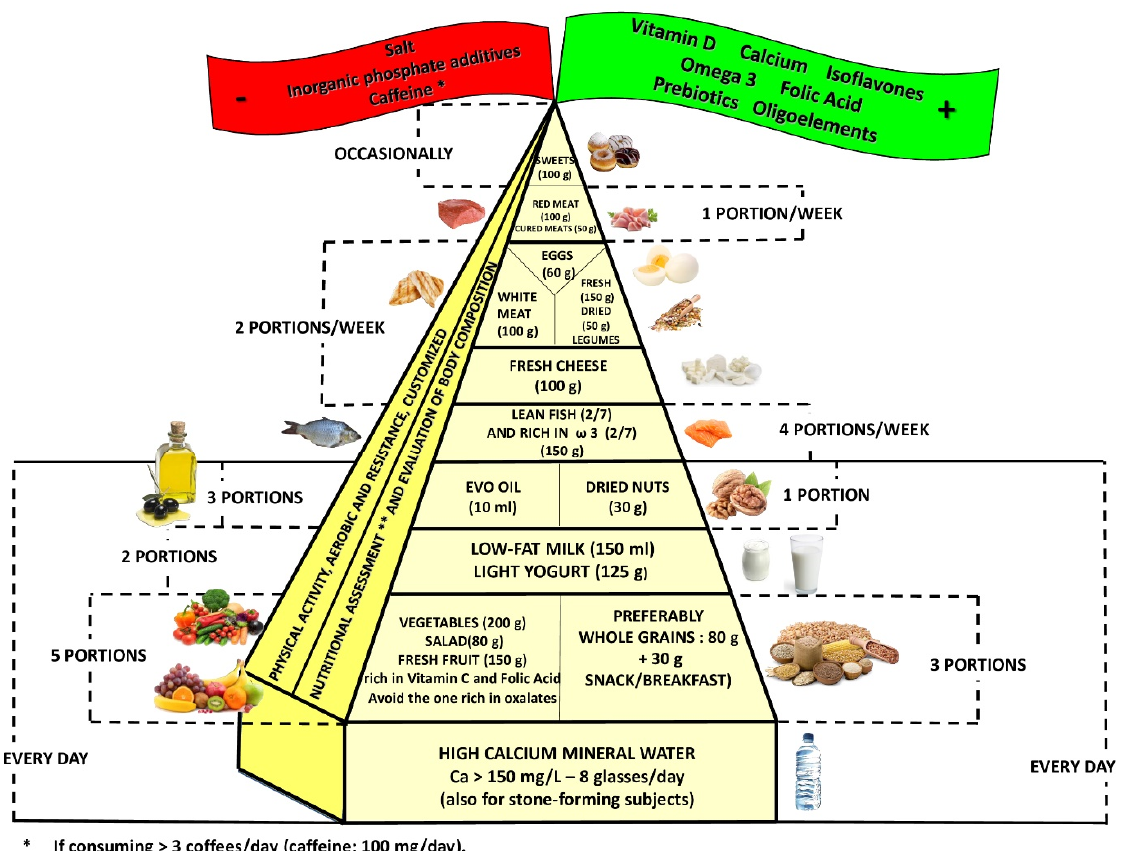
Figure 2. Ideal food pyramid for patients with osteopenia/osteoporosis. “+”, one green pennant, means that osteopenia/osteoporosis subjects need some personalized supplementation (if daily requirements cannot be satisfied through diet, calcium, vitamin D, boron, omega 3, and isoflavones supplementation could be an effective strategy with a great benefit/cost ra-tio); “-”, one red pennant, means that there are some foods that are banned (salt, sugar, and in-organic phosphate additives).